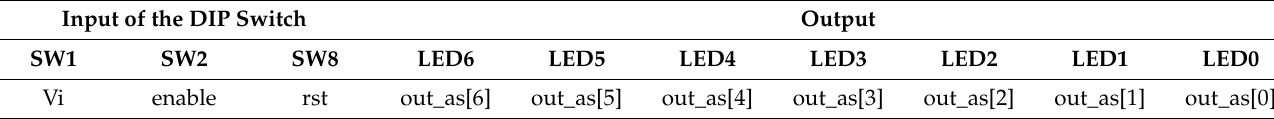
Table 4. Input and output configuration for the Virtex-6 ML605 FPGA board.